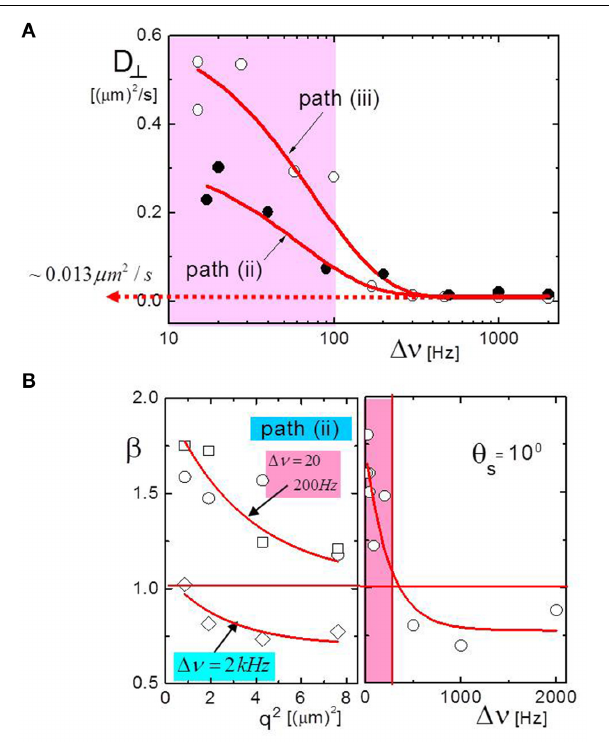
FIGURE 7 | (A) The diffusion coefficient for motion perpendicular to the external field D ⊥ as a function of the frequency gap from the transition frequency of the H-N ∗ transition line, for the two paths (ii) and (iii). (B) The stretching exponent, β , as a function of the squared wave vector q for two different frequencies (left panel) and as a function of the frequency along path (ii) at a fixed scattering angle (right panel).